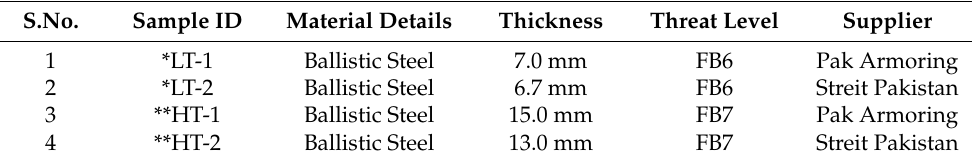
Table 1. The materials utilized in the present